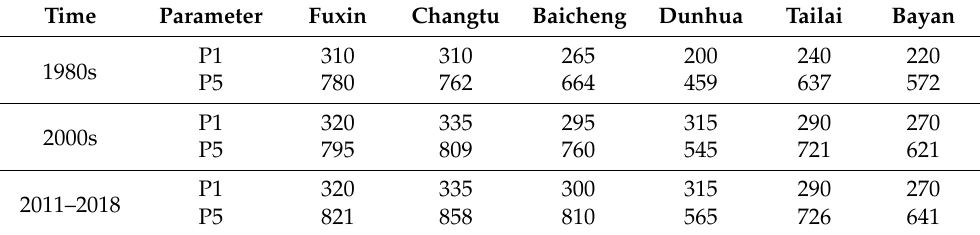
(Table 1). In addition, averages of TTs from anthesis to physiology maturity during the 1980s and 2000–2018 were used as TTs from silking to physiological maturity (P5, expressed in degree days above a base temperature of 8 ◦ C) for the crop model simulation (Table 1). Table 1. Parameters P1 and P5 in the CERES-Maize model during the 1980s and 2000–2018 for the six stations. Time Parameter Fuxin Changtu Baicheng Dunhua Tailai Bayan P1 310 310 265 200 240 220 1980s